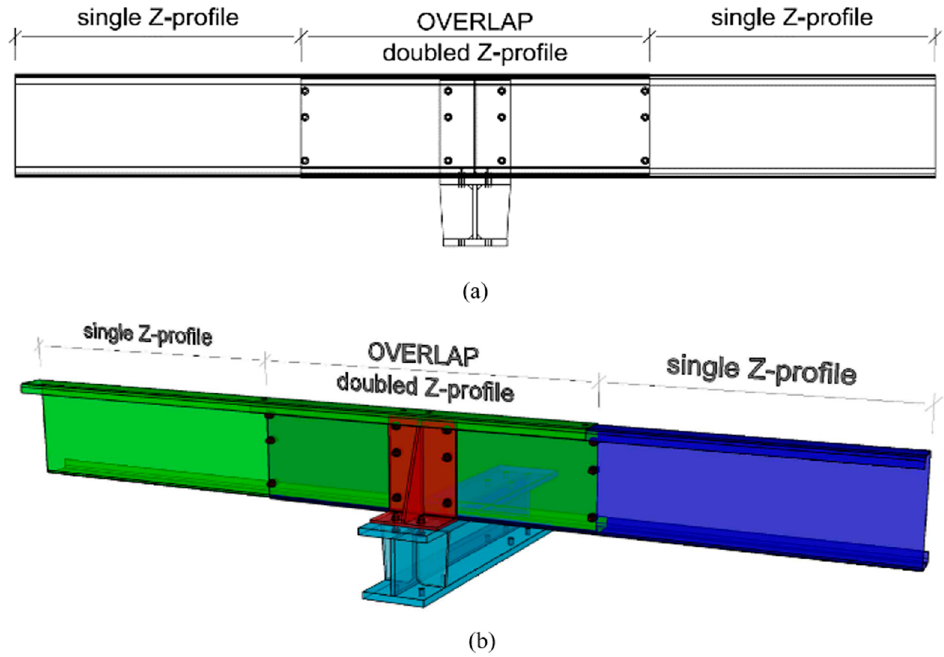
Figure 1. ( a ) Diagram of purlins connected on the main roof structure and ( b ) 3D model of the connection.